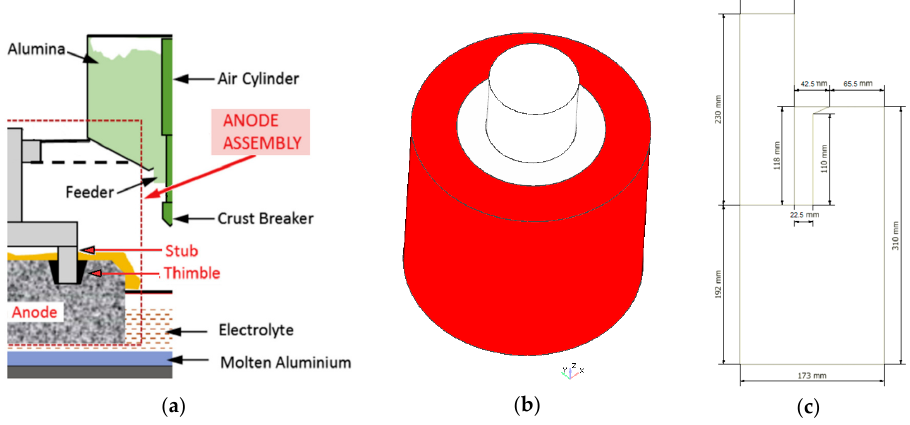
Figure 1. ( a ) Hall-Héroult electrolytic cell [3] (Reproduced with permission from Gunasegaram and Molenaar [3], Elsevier Ltd., 2013); ( b ) stub-to-carbon (STC) assembly: stub (light gray), thimble (dark gray) and carbon anode (red), Longitudinal axis (blue arrow) and radial axis (red arrow); ( c ) Half slice geometry used for the simulations, dimensions in mm, longitudinal-radial plane.